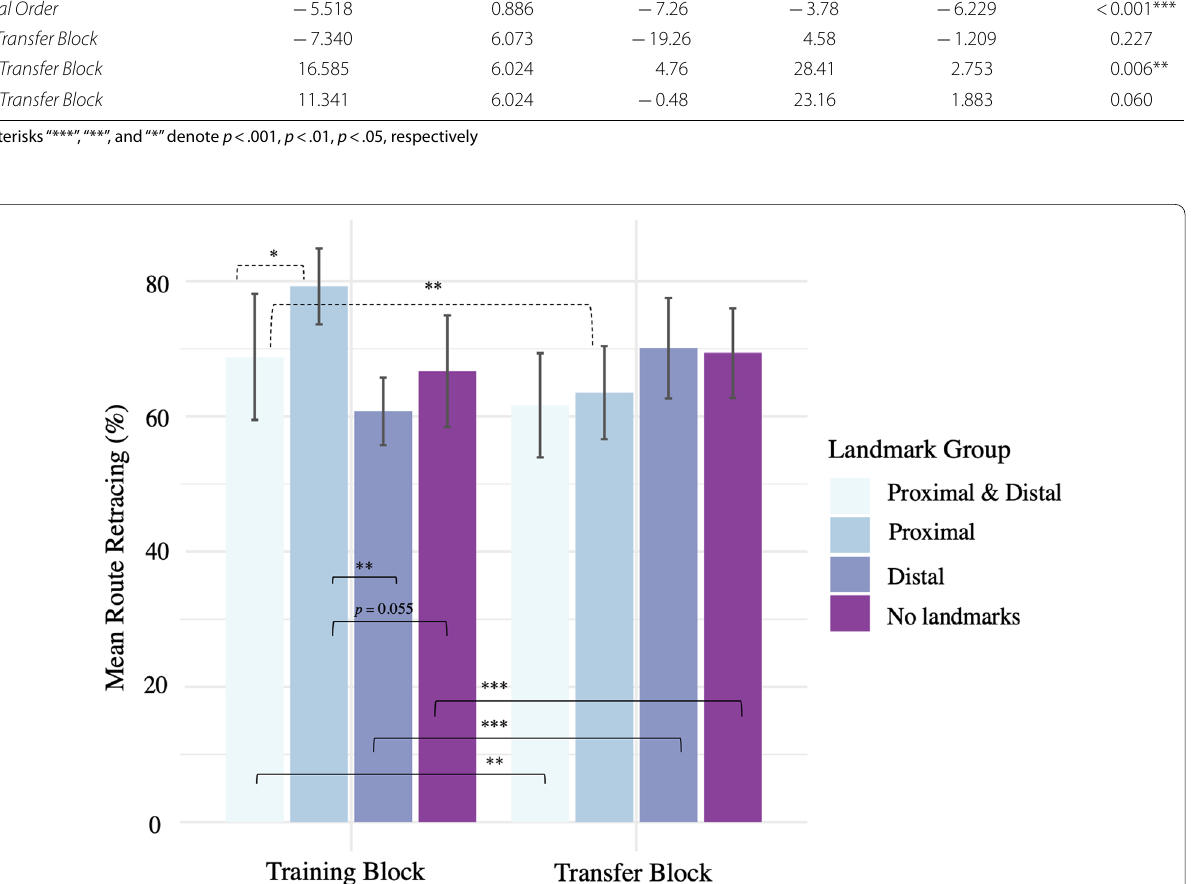
Fig. 4 Route retracing for each Landmark group and Block, for all trials. Error bars are 95% confidence intervals. Black dashed lines indicate significant model interactions and black solid lines indicate significant pairwise comparisons. Asterisks “***”, “**”, and “*” denote p < .001, p < .01, p < .05,